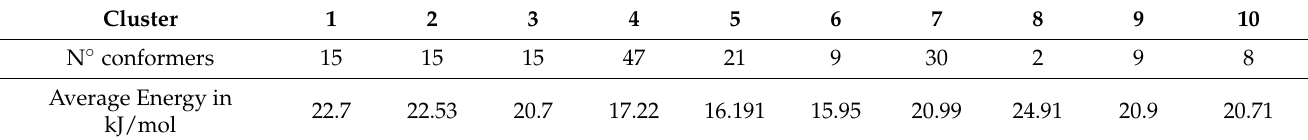
Table 1. Number of conformers and average energy of each conformational analysis cluster.